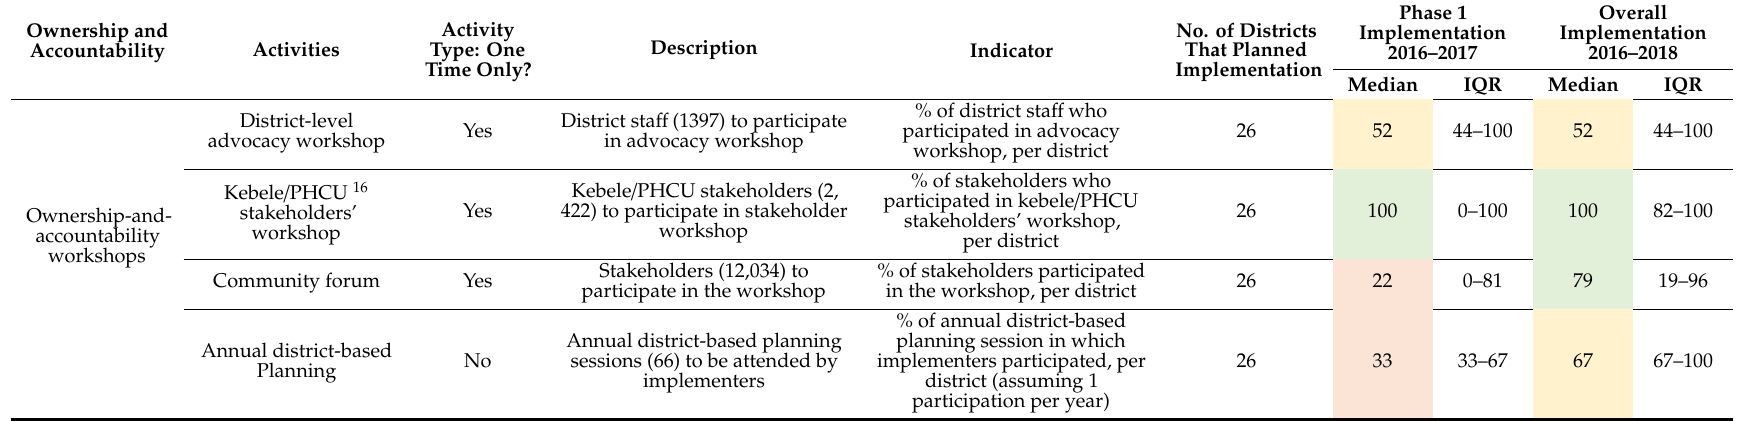
Table 3. Fidelity of implementation activities under ownership / accountability strategy in 26 districts categorised by implementation year (2016–2017 and 2018)